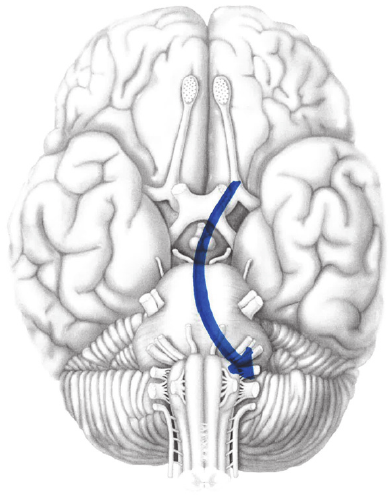
Figure 1: Diagrammatic representation of local anesthetic spread along brainstem from CN II to CN